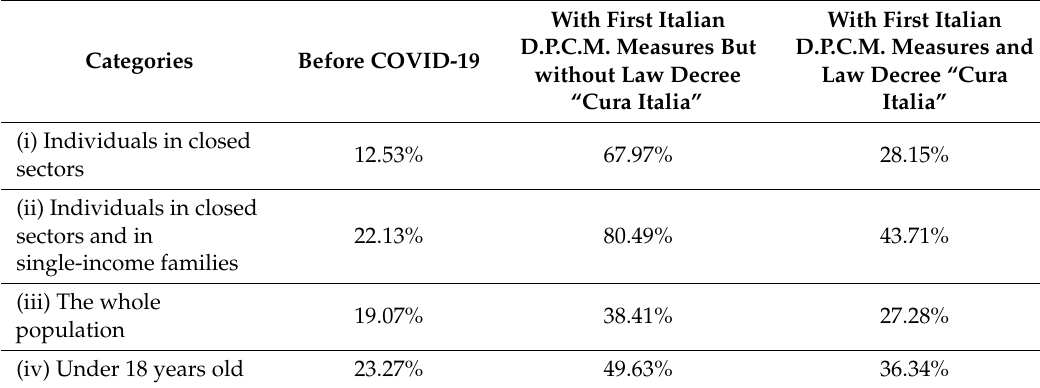
Table 2. Poverty rate before and after the health COVID-19 crisis